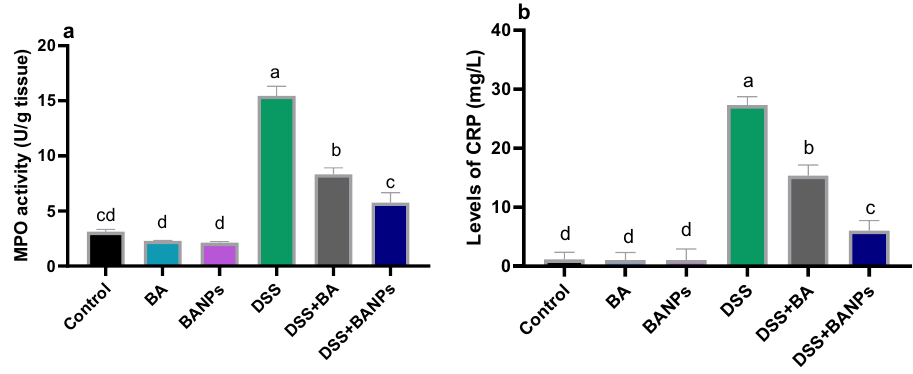
Figure 3. Effects of orally administered B. amyloliquefaciens ( BA ) or BA-nanoparticles (BANPs) in non- colitic and colitic rats on colonic myeloperoxidase (MPO) activity ( a ) and serum C-reactive protein (CRP) levels 7 days post DSS induction. Non-colitic groups including Control, BA and BANPs groups where rats were orally gavaged PBS, B. amyloliquefaciens and B. amyloliquefaciens loaded nanoparticles (BA at level of 1.0 × 10 10 CFU/kg in 1 mL of PBS/rat/day), respectively, for 7 days. Colitic groups: DSS, BA and BANPs groups where rats were orally gavaged dextrane sodium sulphate (DSS), B. amyloliquefaciens + DSS and B. amyloliquefaciens loaded nanoparticles (BA at level of 1.0 × 10 10 CFU/kg in 1 mL of PBS/rat/day) + DSS , respectively, for 7 days. All groups orally gavaged by 5% DSS. Values are expressed as mean ± SE, a,b,c Means of the bars with different letters were significantly different among groups ( P <